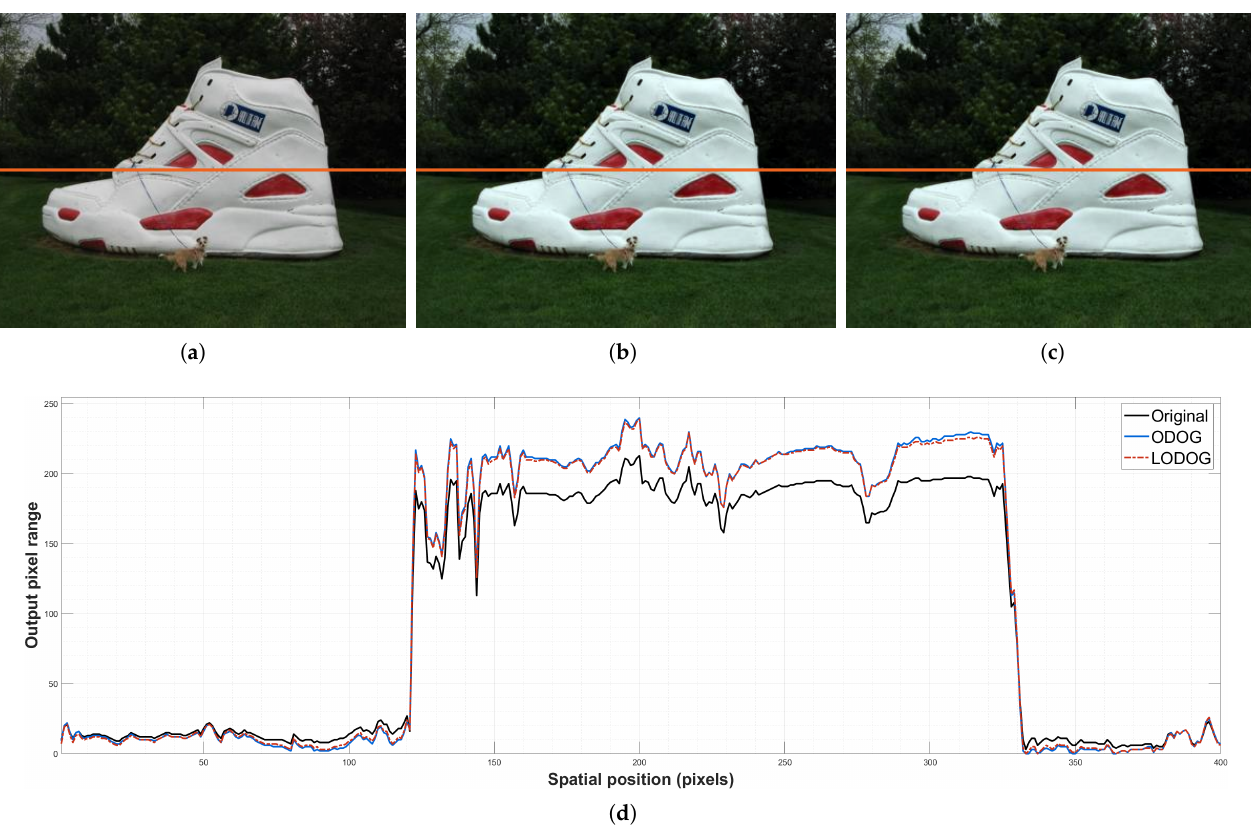
Figure 3. Comparison of results after applying ODOG and LODOG filters to image. ( a ) Input original image; ( b ) ODOG result image; ( c ) LODOG result image; ( d ) predicted pixel value of perceived brightness for the spatial position indicated by the red line in ( a – c